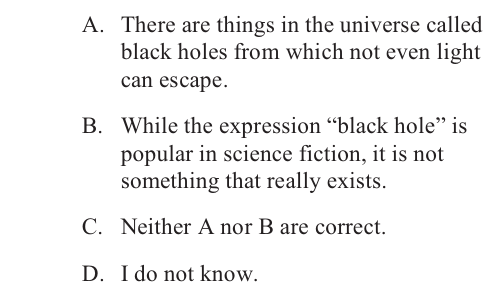
FIG. 2. Post-test question given to all students at the end of the summer program. Black holes were not